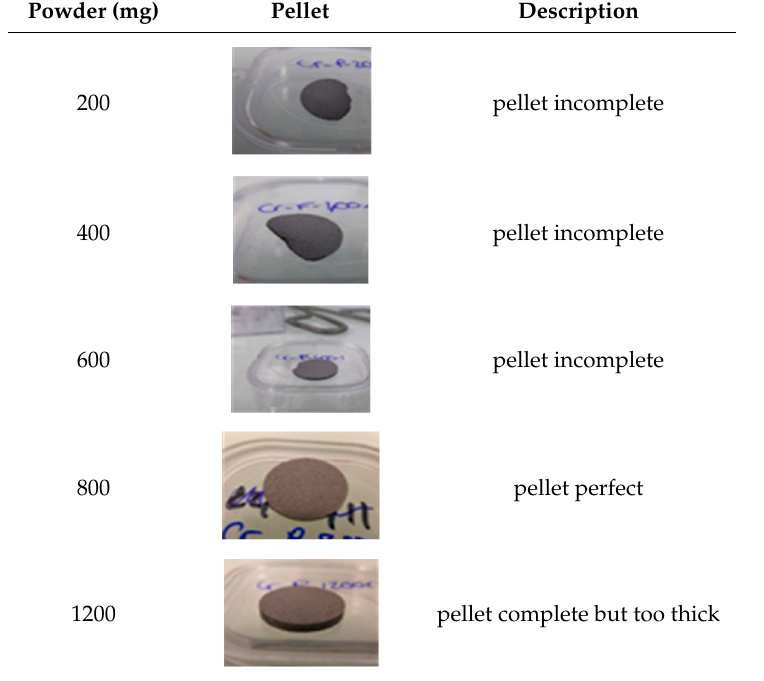
Table 5. Various mass of pellet of Cr.